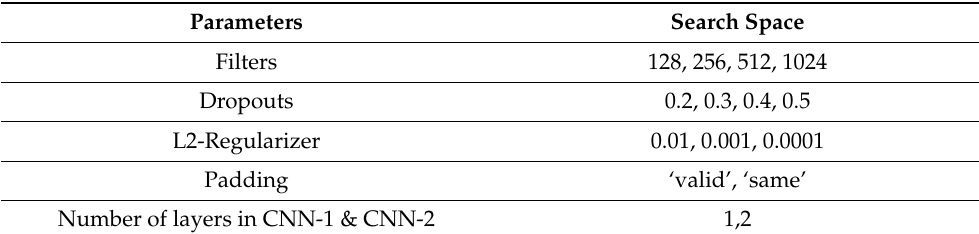
Table 3. Search space used for various parameters during parameter optimization.